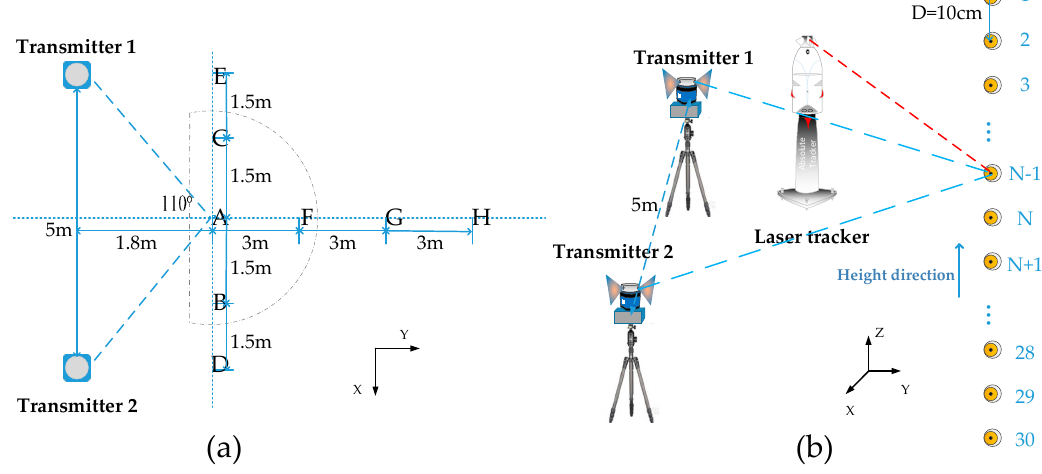
Figure 6. The schematic of the comparison experiments of coordinate measurement. ( a ) The space layout; ( b ) The distribution of test points in each group.